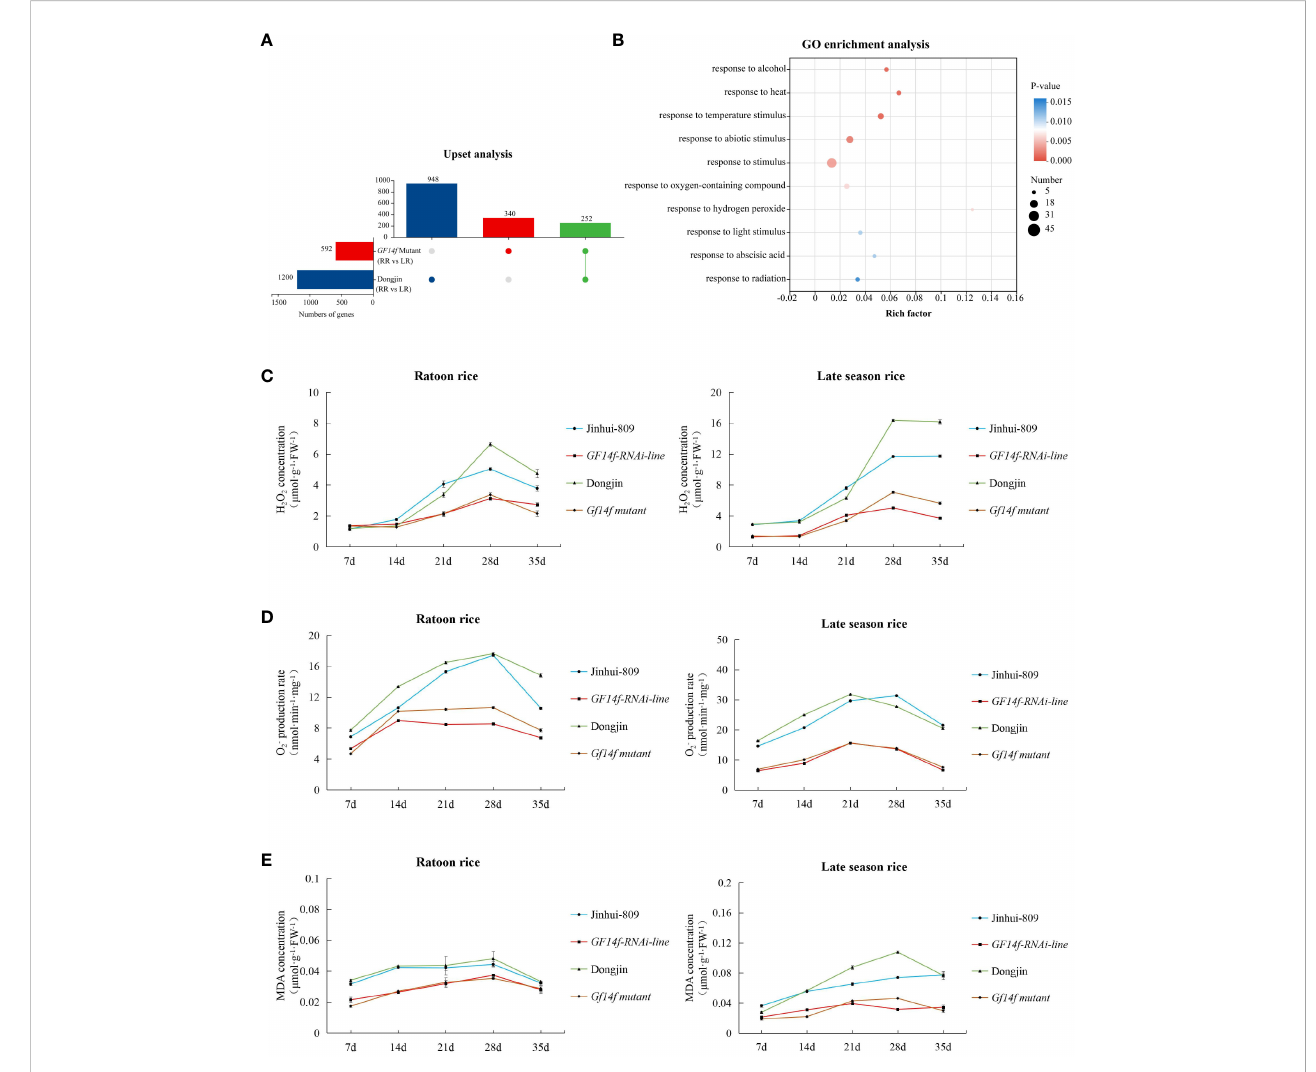
FIGURE 4 GF14f gene modulates the gene-dependent response to environmental stimuli underlying rice ratooning (A) Up-set analysis of GF14 mutant and its WT. (B) : Go enrichment analysis (TOP 10) of the 252 key DEGS which were differentially expressed in the pathways of both the GF14f mutant and the corresponding WT. GO database (http://www.geneontology.org/) was used to annotate the DEGs. The data showing the differentially expressed genes were visualized using Circos (Version 0.69, http://circos.ca/). Each gene was classi fi ed as belonging to their sample groups and was assigned to one special color in chordal diagram. (C) Temporal pattern of H 2 O 2 concentration during grain- fi lling stage. (D) Temporal pattem of O − 2 production rate during grain- fi lling stage. (E) Temporal pattern of MDA concentration during grain- fi lling